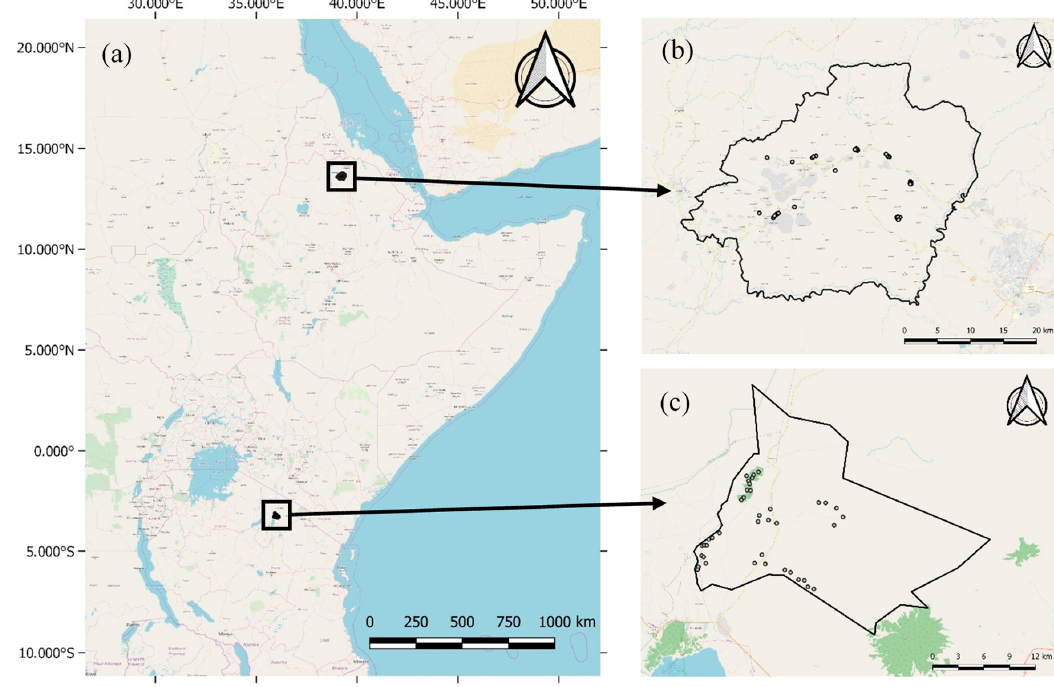
Figure 1. ( a ) Map showing the study sites across East Africa; ( b ) Location of sampling plots in the Degua Tembien district, Ethiopia; ( c ) Location of sampling plots in the Monduli district, Degua Tembien district, Ethiopia; (c) Location of sampling plots in the Monduli district, Tanzania. Each of the plots included three subplots of 400 m². Their location relative to the plot centre was defined using a random distance and angle, with the requirements that (i) each subplot was in a different third of the plot, and (ii) the edges were located at least 10 m from each other and from the border of the plot. In every subplot, each tree or woody shrub with a stump diameter of at least 3 cm was counted as mature, while the others were considered saplings. For each mature tree, the crown diameters (i.e., the longest diameter and the diameter perpendicular to the first one) and the species were noted. The crown areas of all woody plants were then added per subplot, averaged over the three subplots and extrapolated to an area of 1 ha to produce single woody cover measurements per plot.